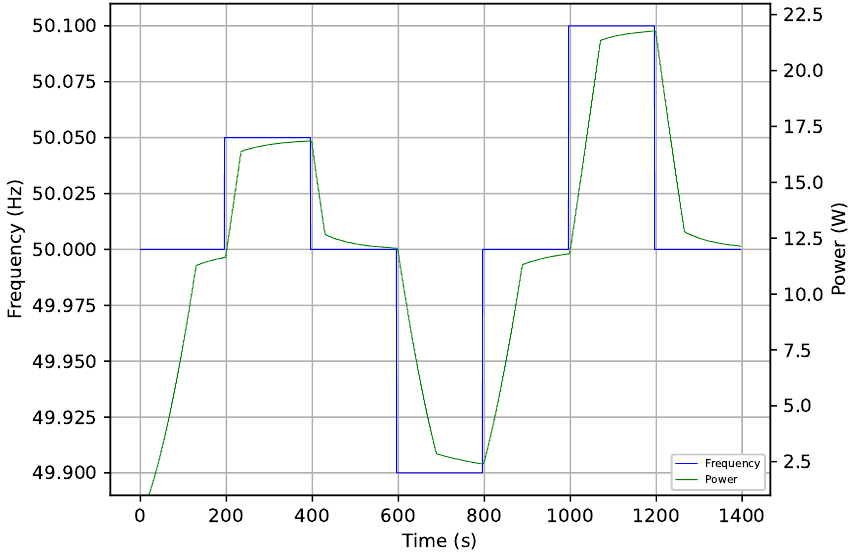
Figure 9. Step response of the continuously controlled LED, where the linear control curve has a slope of 1% (capacity activation per